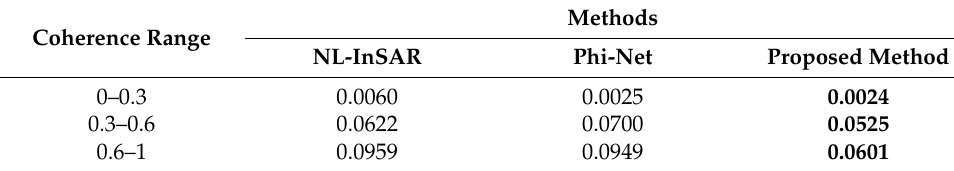
Table 6. Mean square error of the compared methods on simulated coherence